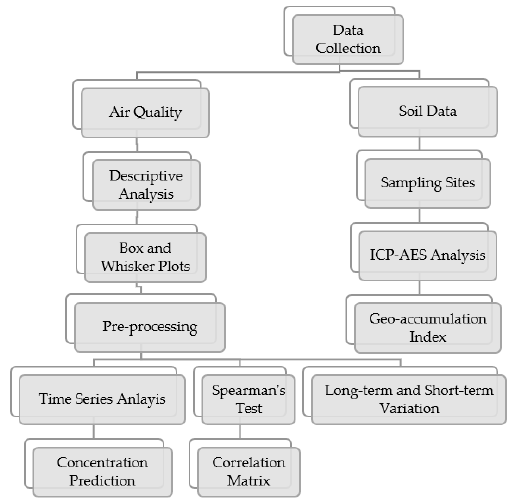
Figure 3. Detailed flowchart of methodology